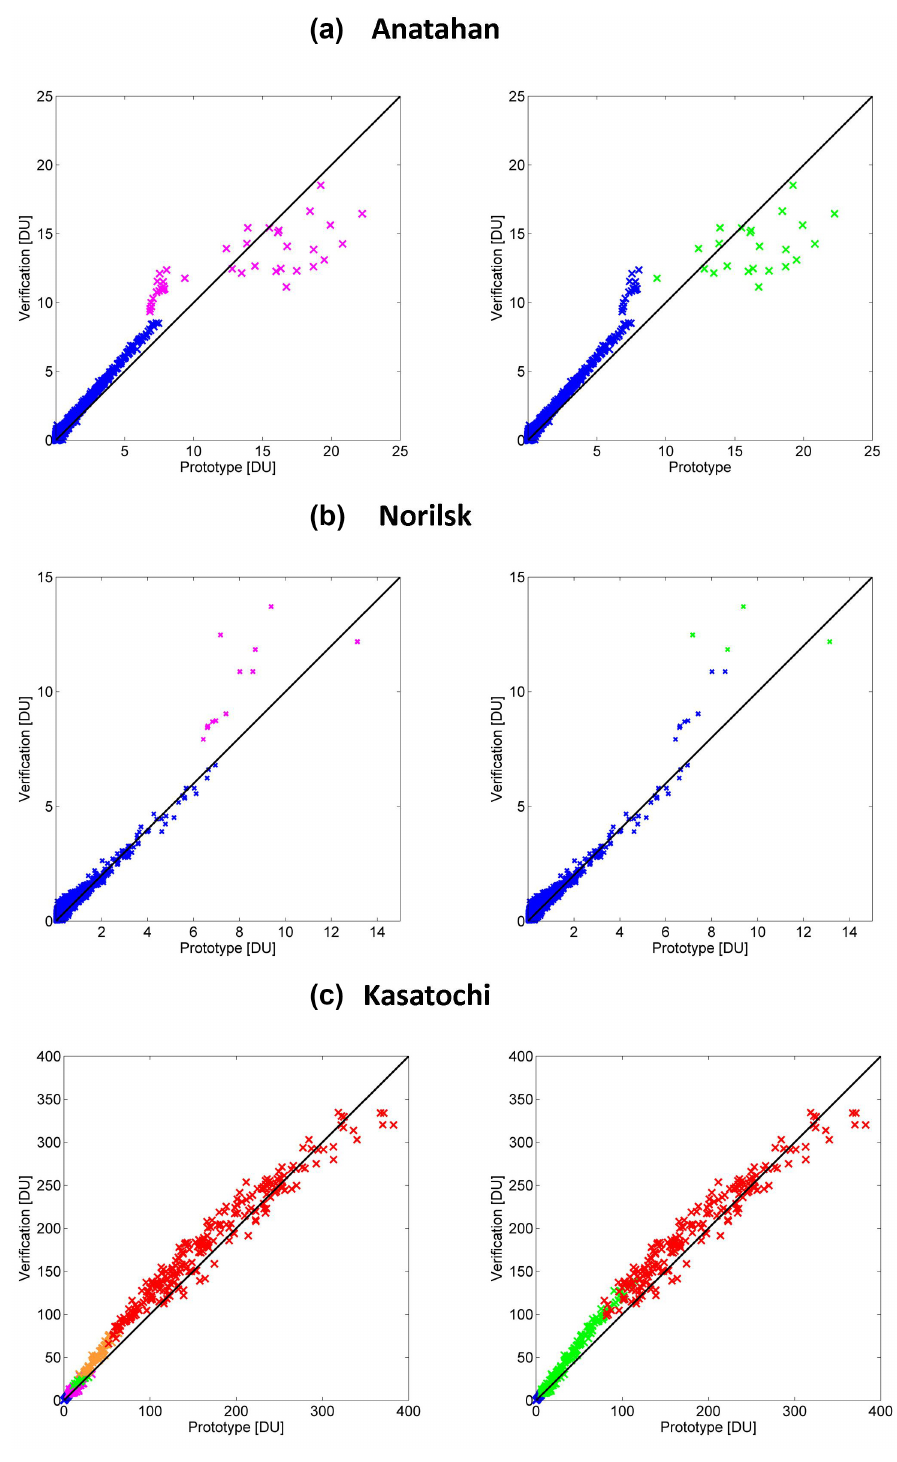
Figure 10. OMI SO 2 VCD (DU) scatter plots for PA ( x axis) and VA ( y axis) for the three test cases: the Anatahan eruption, Norislk anthropogenic emissions and the Kasatochi eruption (from top to bottom). The different fit windows used for both algorithms are color- coded: VA on left panels (blue: SR; purple: SR/MR; green: MR; orange: MR/AR; red: AR), PA on right panels (blue: 312–326nm; green: 325–335nm; red: 360–390nm). For the three scenarios, the prototype and verification algorithms agree fairly well with r 2 ∼